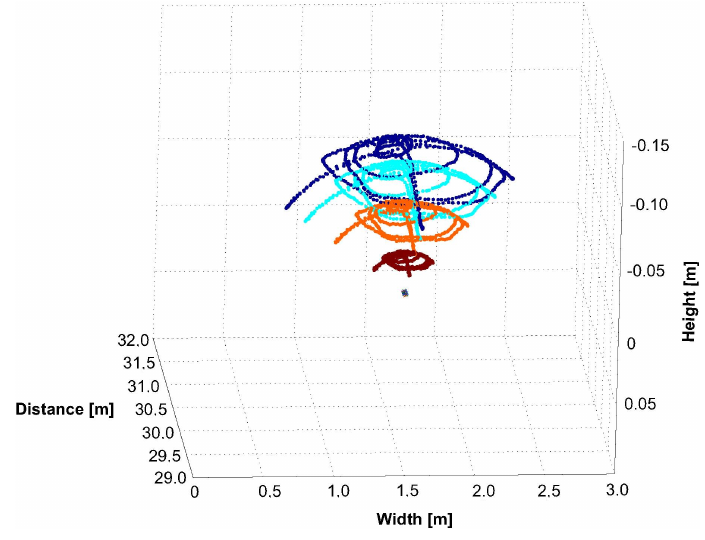
Figure 27. Target movement during accuracy and stability